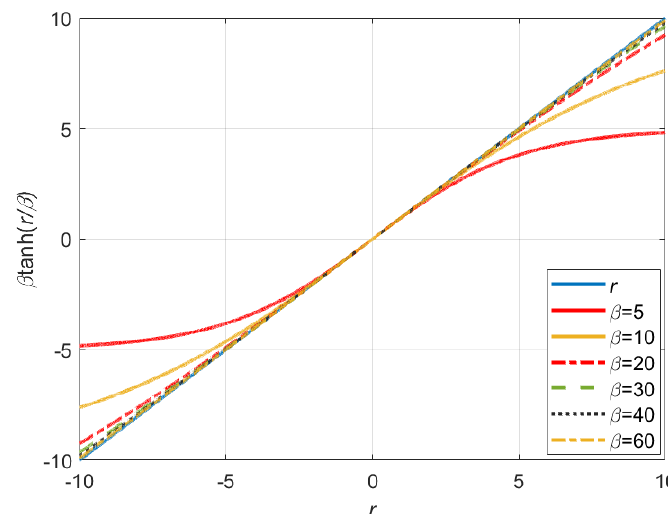
Figure 2. Flowchart of the proposed method.